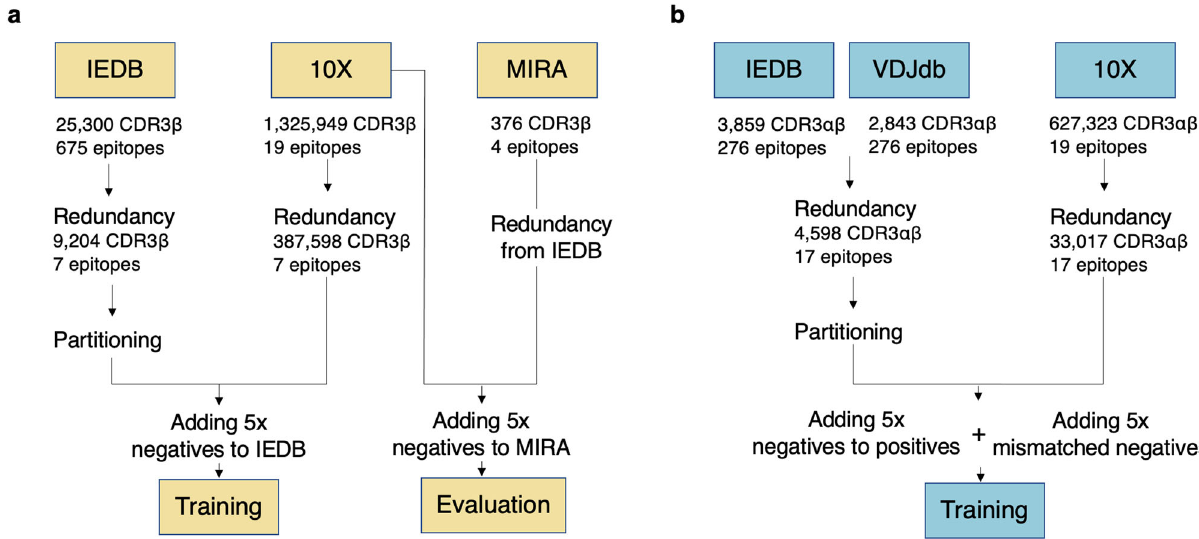
Fig. 9 Data-partitioning pipeline schematics. a Data-preparation pipeline for the β -chain data; b pipeline for the paired-chain data. The positive and negative data sets were each redundancy-reduced with the Hobohm 1 algorithm, according to a Levenshtein similarity threshold. The redundancy-reduced set of positives was partitioned into fi ve groups using a single-linkage clustering algorithm. Negative data were subsequently added to each partition: for each peptide, 5 times the number of positives was randomly selected from the pool of nonredundant negative data. In a , to ensure that the MIRA external evaluation data did not share similarity with the training set, positive points from the MIRA set with a Levenshtein similarity above a certain threshold were removed. Each step of the pipeline is described in detail in the text.